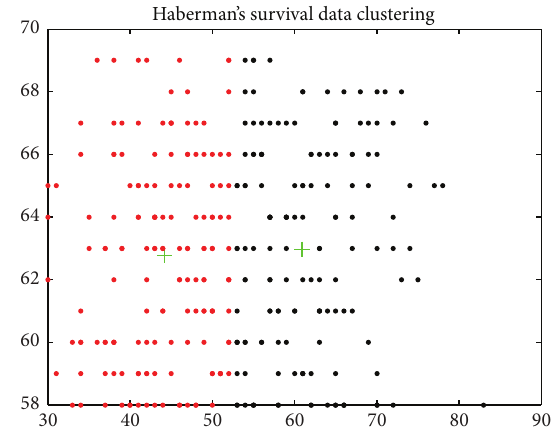
Figure 19: The Iris data clustering result.